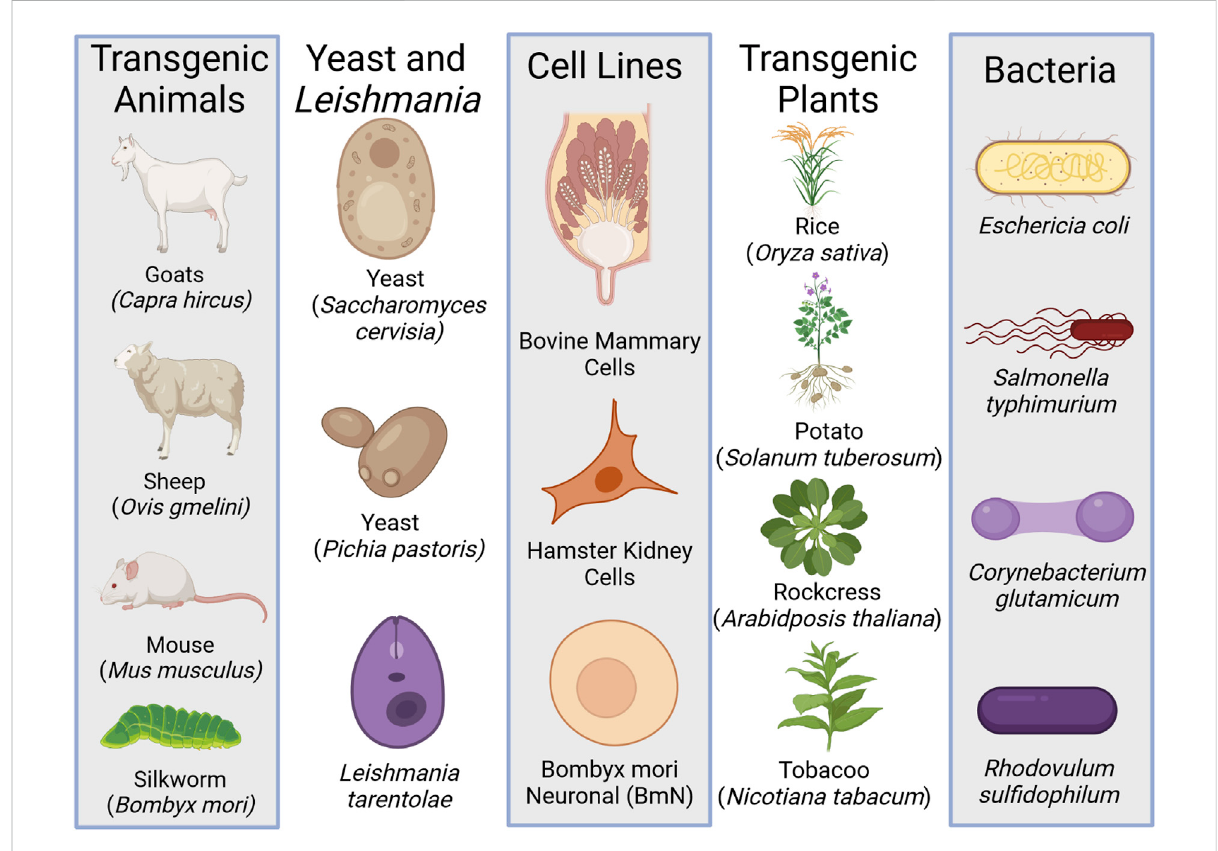
FIGURE 3 The different heterologous expressions systems used to produce recombinant spider silk protein (rSSP). Created with